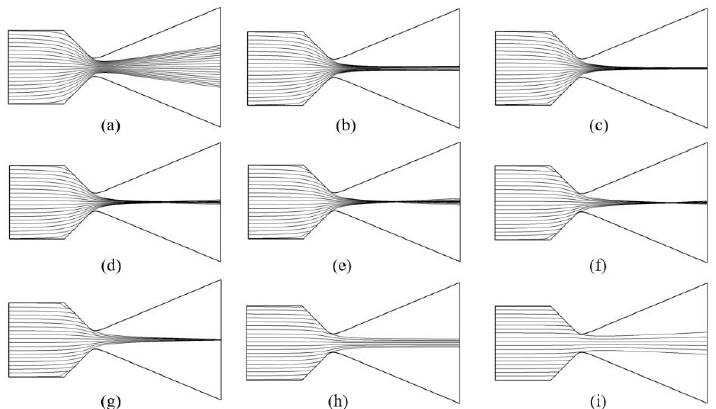
Figure 10. Al particle trajectory in the micronozzle with S f = 0.5 for: ( a ) d p = 0.3 µm (divergence process(I-a)); ( b ) d p = 0.6 µm (collimation process(I-b)); ( c ) d p = 0.7 µm (a focused beam(I-c)); ( d ) d p = 0.8 µm (intersection process(II)); ( e ) d p = 1.0 µm (intersection process(II)); ( f ) d p = 1.4 µm (intersection process(II)); ( g ) d p = 1.6 µm (a focused beam(III-c)); ( h ) d p = 2.2 µm (collimation process(III-b)); ( i ) d p